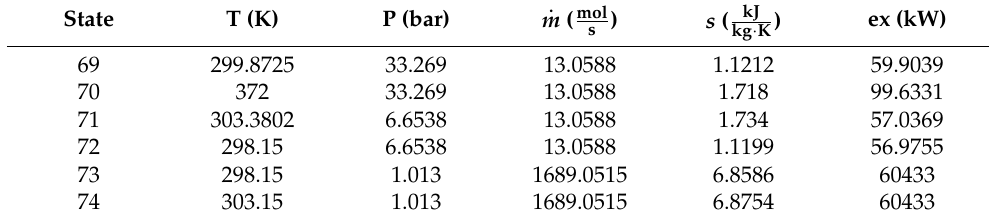
Table 4. The thermodynamic properties of the state variables in the ORC.